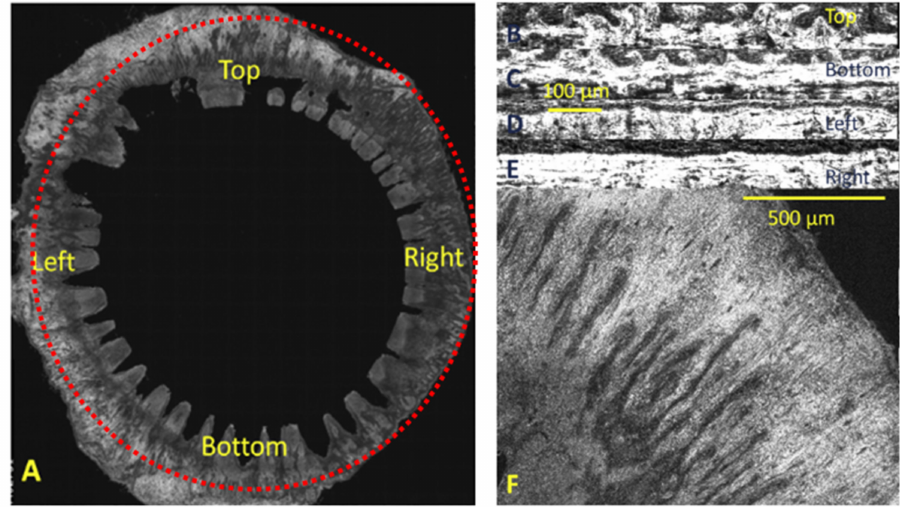
Figure 11. Morphological features of the human limbal zone. ( A ) Entire 360 o corneoscleral rim where the corneal button has been removed for keratoplasty. ( B – E ) Cross-sections at top, bottom, left and right locations, revealing that in this sample, crypts were visible on the vertical but not the horizontal axis. ( F ) Widefield view of corneoscleral rim portion. Reprinted and adapted with permission from Grieve et al. (2015)